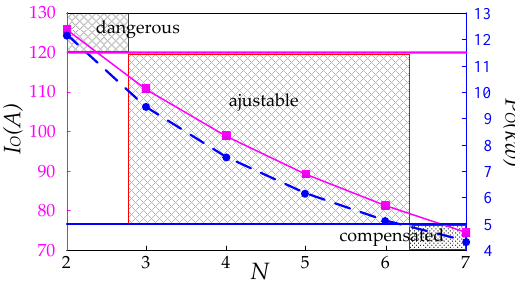
Figure 3. Primary current and receiving power according to EV numbers.